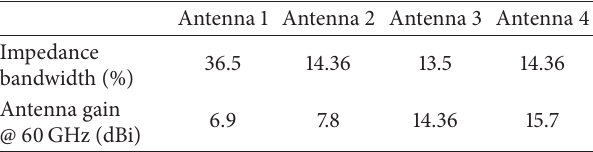
Figure 27: Rectangular DRAwith superstratefor gain improvement as suggested in [63]. Table 9: Performance comparison between the DRAs shown in Figure